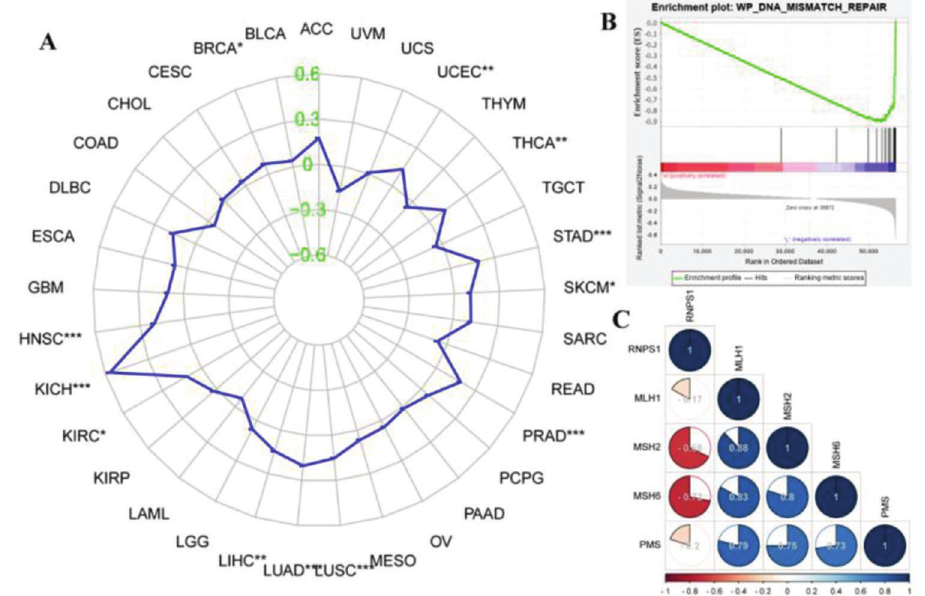
Figure 5 - (A) Pan-cancer assays of MSI in different cancers. (B) GSEA of the correlation between RNPS1 and MMR in UCEC. (C) Analysis of the correlation of RNPS1 with MSH1, MSH2, MSH6, and PMS2 in